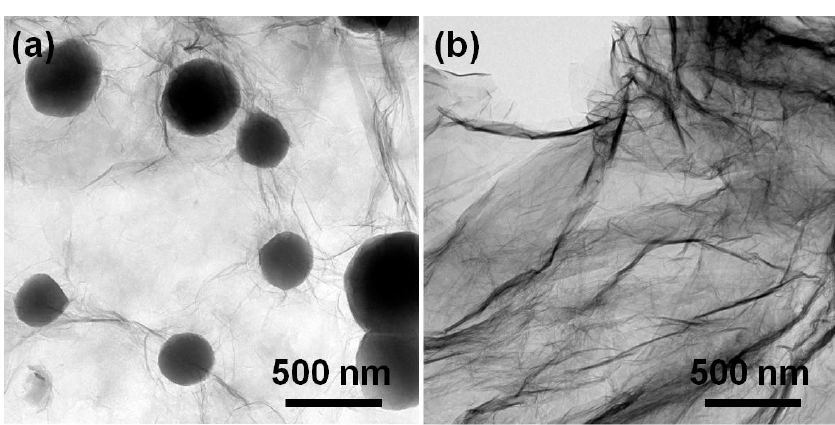
Figure 3. TEM images of PPy/rGO-S2 ( a ) and rGO ( b ).